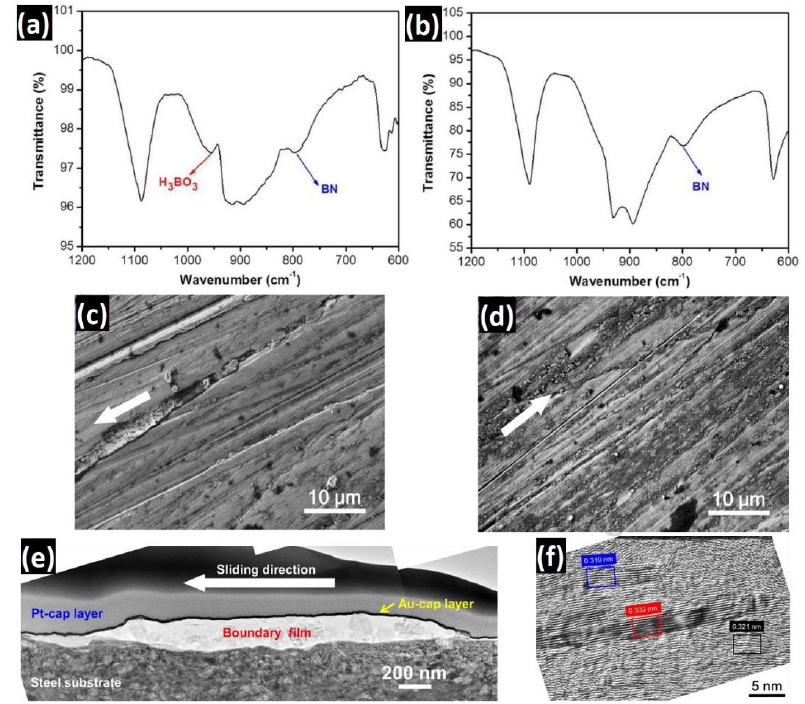
Figure 14. ATR-FTIR spectra of surface areas within ( a ) and outside ( b ) of the wear scar of POM / 3hBN at applied load of 200 N; SEM graphs of the steel counterface after rubbing with ( c ) neat POM and ( d ) POM / 3h-BN at applied load of 200 N (Arrows indicate the sliding directions); ( e ) overview of the TEM graph of focused ion-beam cut cross-section of the boundary film formed on steel surface after sliding against POM / 3hBN at 200 N; ( f ) high resolution TEM (HR-TEM) graph of the outmost layer of the boundary film (Reprinted with permission from Elsevier, Copyrights 2017) [134].